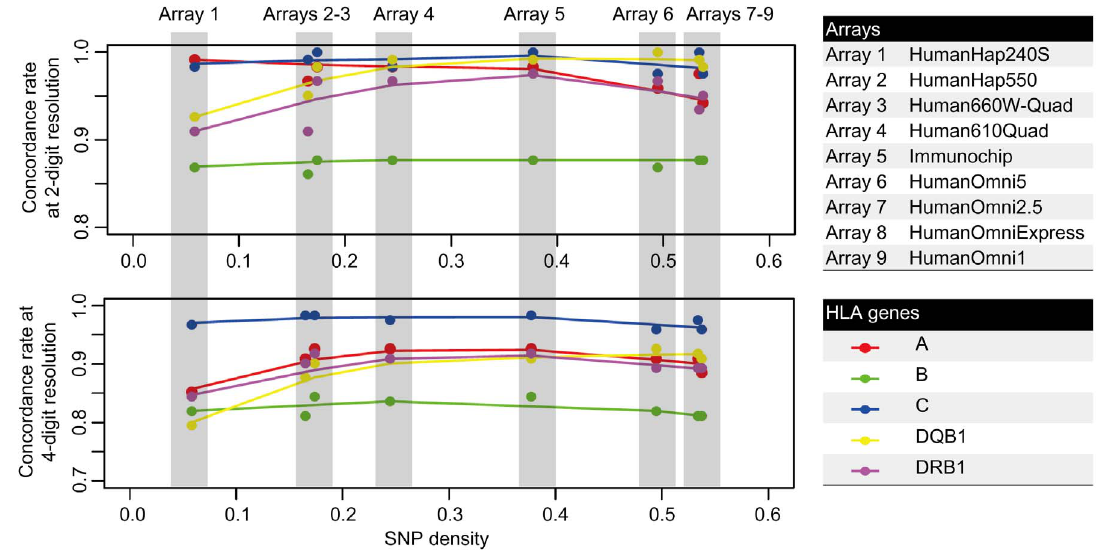
Figure 1. Concordance rates using various reference panels. SNPs present in 9 different commercial arrays were extracted for imputing the HLA alleles from the HapMap3 r2 dataset of East Asian (CHB + JPT) individuals. Each subset was imputed for HLA-A , -B , -C , -DQB1 and -DRB1 using the Korean reference panel. Concordance rates (y-axis) were plotted against the proportion of reference-panel SNPs that were present in each subset (x- axis).